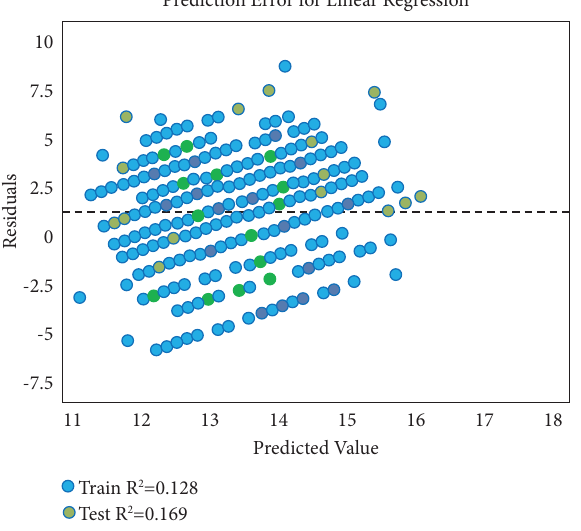
Figure 5: Residual distribution diagram.